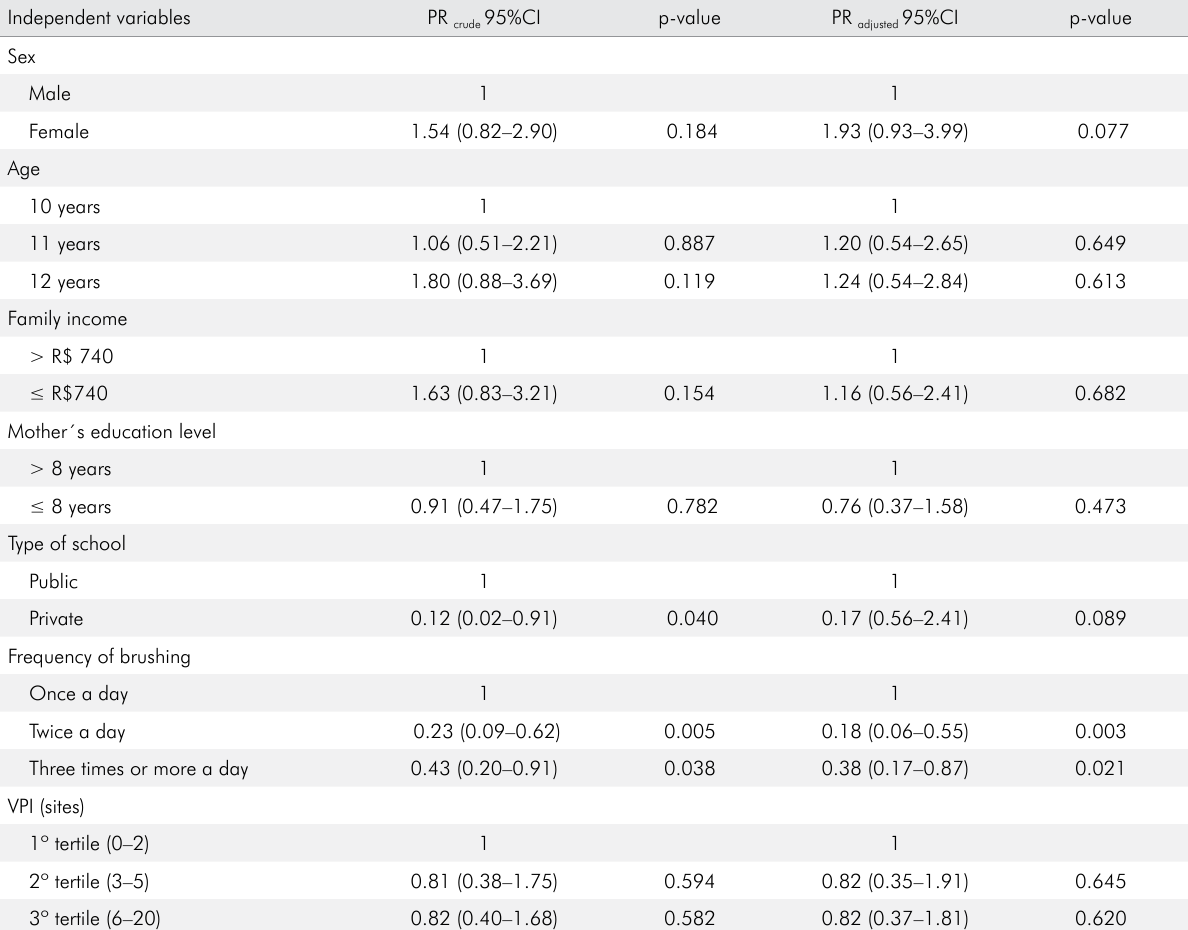
Table 2. Association of dental black stains and independent variables in schoolchildren between 10–12 years old. Poisson regression analysis. Pelotas, 2010 (n =